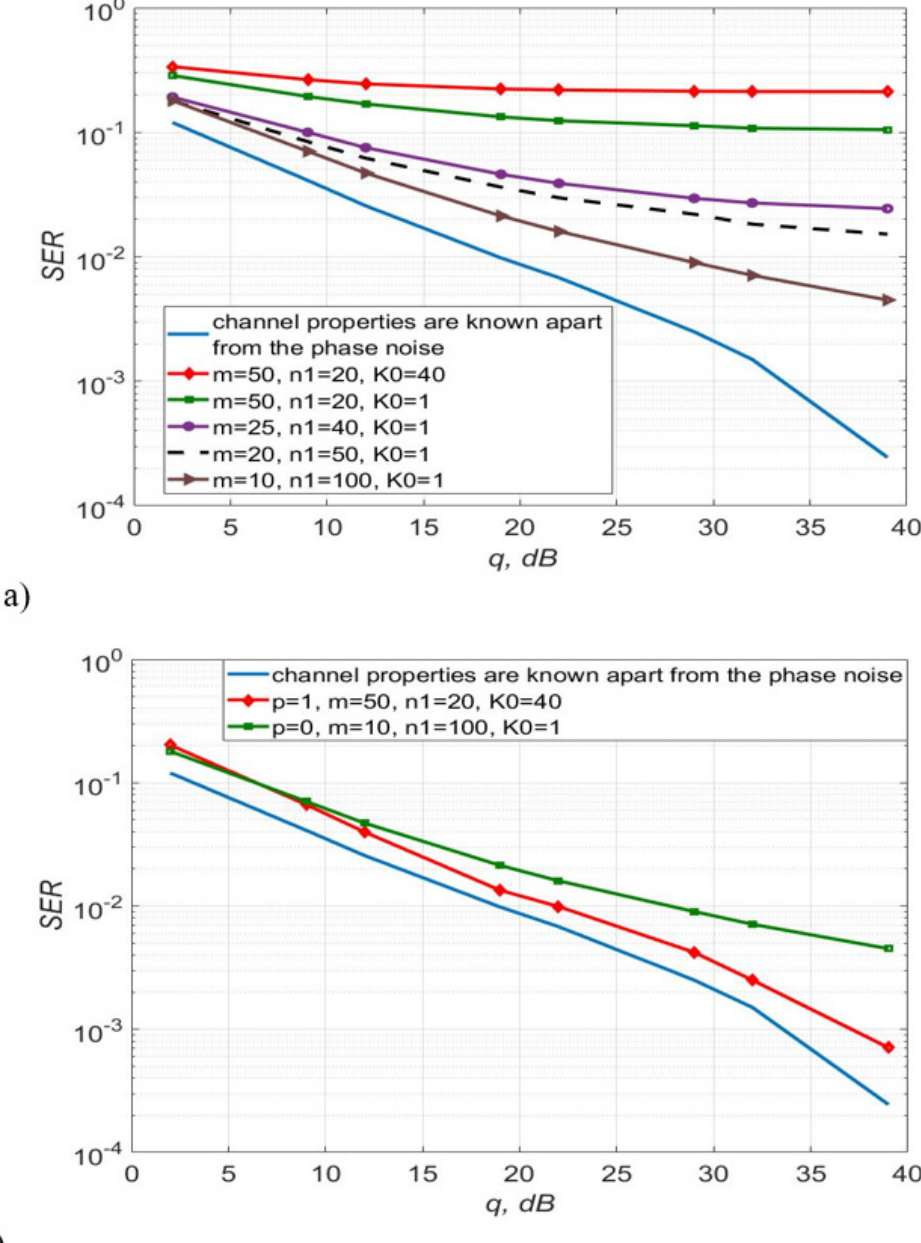
Figure 4. SER of 4-QAM versus SNR per bit for the algorithms, described by Equations (5)–(9) and (12) with polynomial approximation of the zero order—( a ), zero and first orders—( b ).